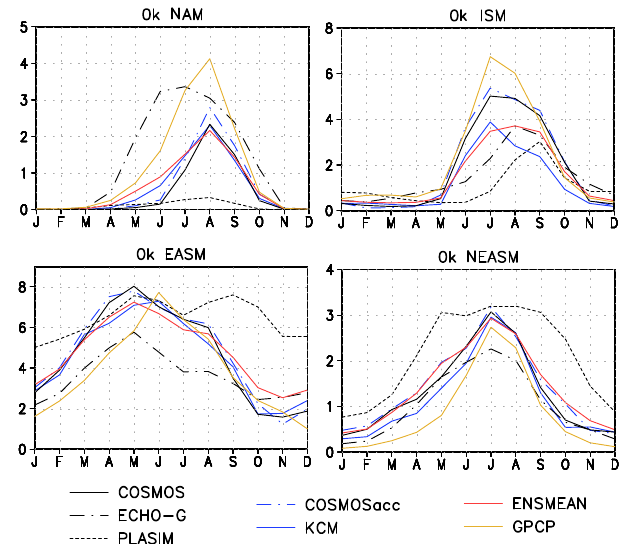
Figure 4. Simulated pre-industrial seasonal precipitation cycle compared to GPCP observational data (in mmday − 1 , based on the years 1979–2008), for different regions in the Afro-Asian mon- soon domain, i.e. the North African monsoon region (NAM), In- dian monsoon region (ISM), East Asian monsoon region (EASM), and the northern part of the East Asian monsoon region (NEASM). Please note the change in